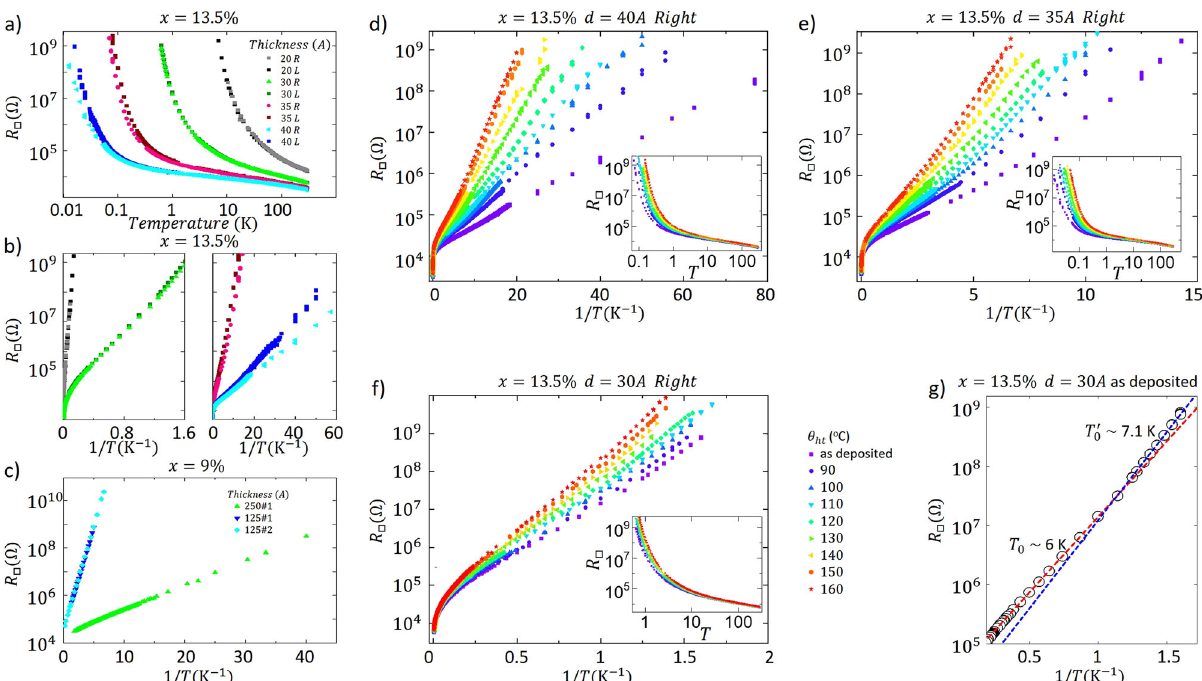
Fig. 1 Low temperature resistance measurements. a Temperature dependence of the sheet resistance of Nb x Si 1 − x for the x = 13.5% as-deposited batch. b Sheet resistance as a function of 1/ T on a semilogarithmic scale to highlight the activated behavior for the x = 13.5% samples. R and L correspond to the right and left sides of the same sample (see ‘ Methods ’ ). c Sheet resistance as a function of 1/ T on a semilogarithmic scale for the as-deposited samples. d − f Effect of successive heat treatments on the sheet resistance of the 13.5% 40 Å ( d ), 35 Å ( e ) and 30 Å ( f ) samples. The insets show the R □ ( T ), while the main panels display the same data as a function of 1/ T . g At low temperature, at about 0.9 K for the 13.5% 30 Å as-deposited fi lm, there is a crossover between two activated regimes. Circles represent the data and dashed lines correspond to linear fi ts with the corresponding activation temperatures ( T 0 and T 0 )